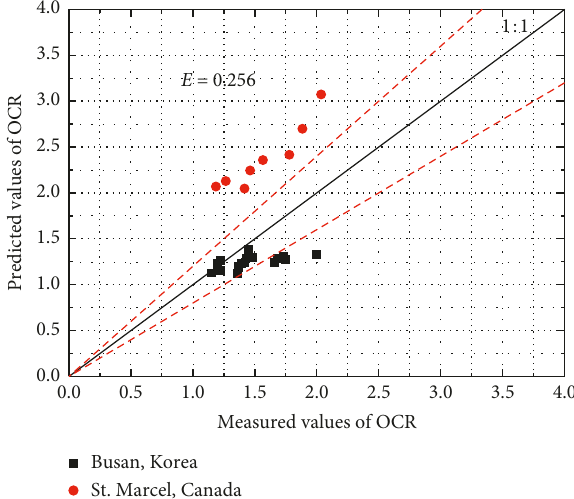
Figure 7: The predicted values of OCR by four methods for St. Marcel site in Canada based on CPTU.